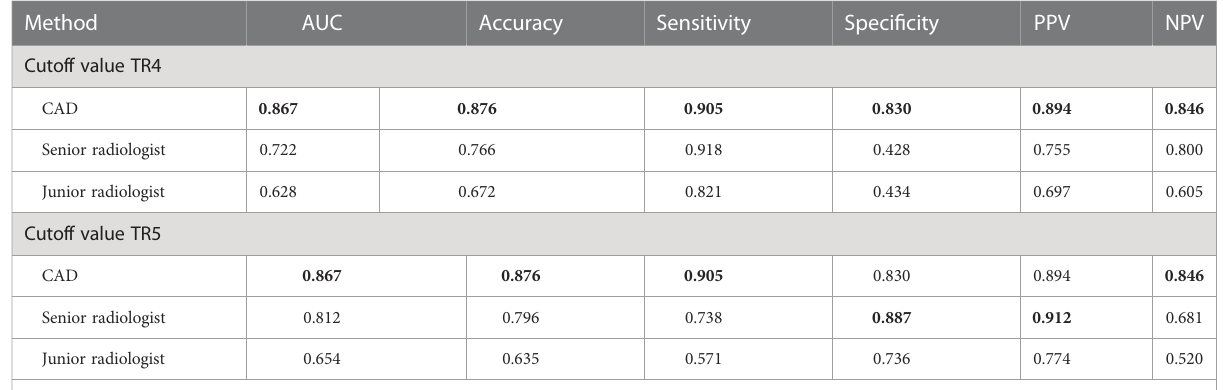
TABLE 2 Quantitative indicators of the CAD system and the two radiologists with different